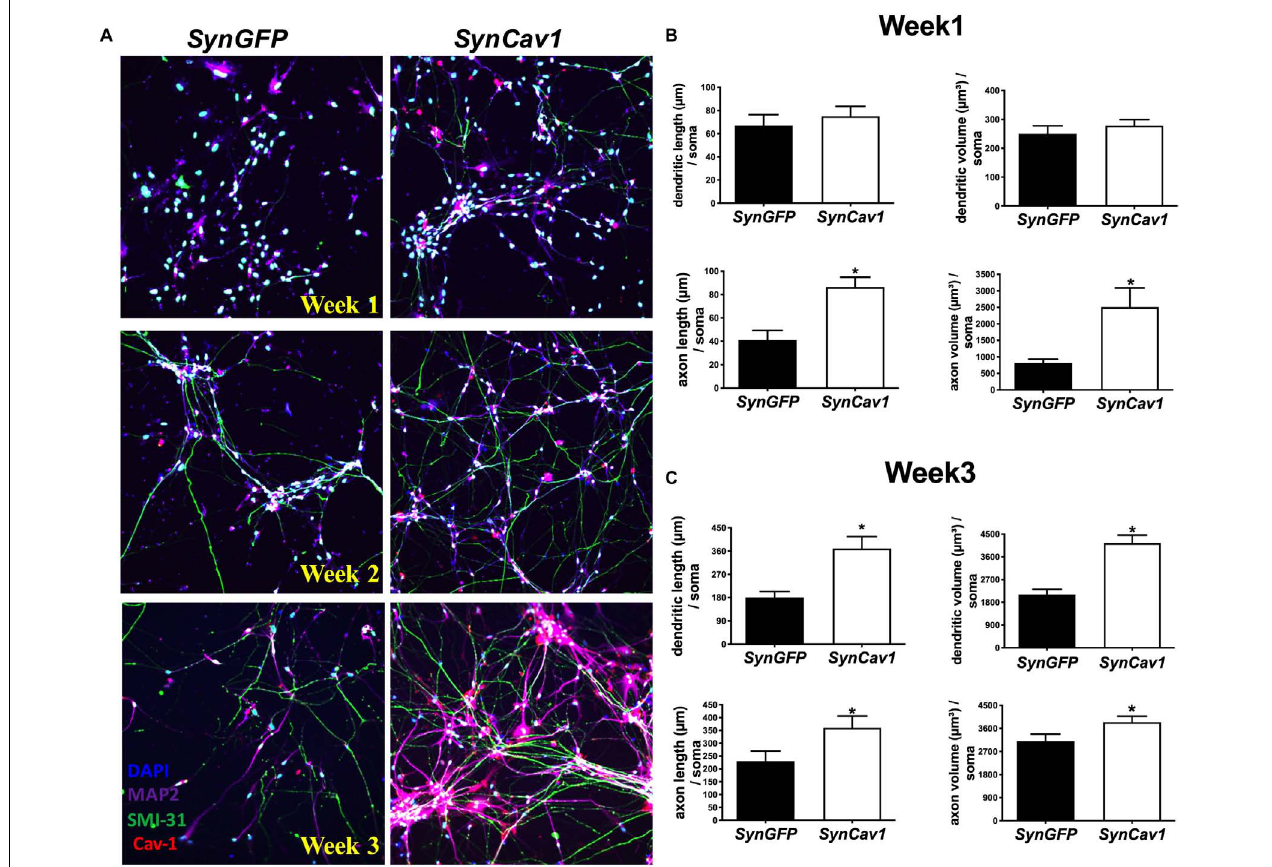
FIGURE 2 | SynCav1 enhances axonal growth in differentiated NPCs derived from human iPSCs. Differentiated NSCs were transfected with lentiviral SynCav1 (2 × 10 9 IU/ µ l) (or SynGFP ) on day 3 for 4 days, IF microscopy was performed at 1–3 weeks post transfection. Representative IF images are shown in (A) . SynCav1 significantly enhanced axonal length (um) and volume (um 3 ) after 1 week (B) and increased both dendritic and axonal length (um) and volume (um 3 ) at 3 weeks (C) as measured by Autoneuron, a tracing algorithm that measures 3D image volume stacks (Head et al., 2011). NPCs were stained for the MAP2 (dendrites and magenta), SMI 31 (axons and green), and Cav-1 (red). 40 × magnification, Nikon confocal microscope. Data are expressed as mean ± S.E ( n = 3, ∗ p < 0.05, t -test).